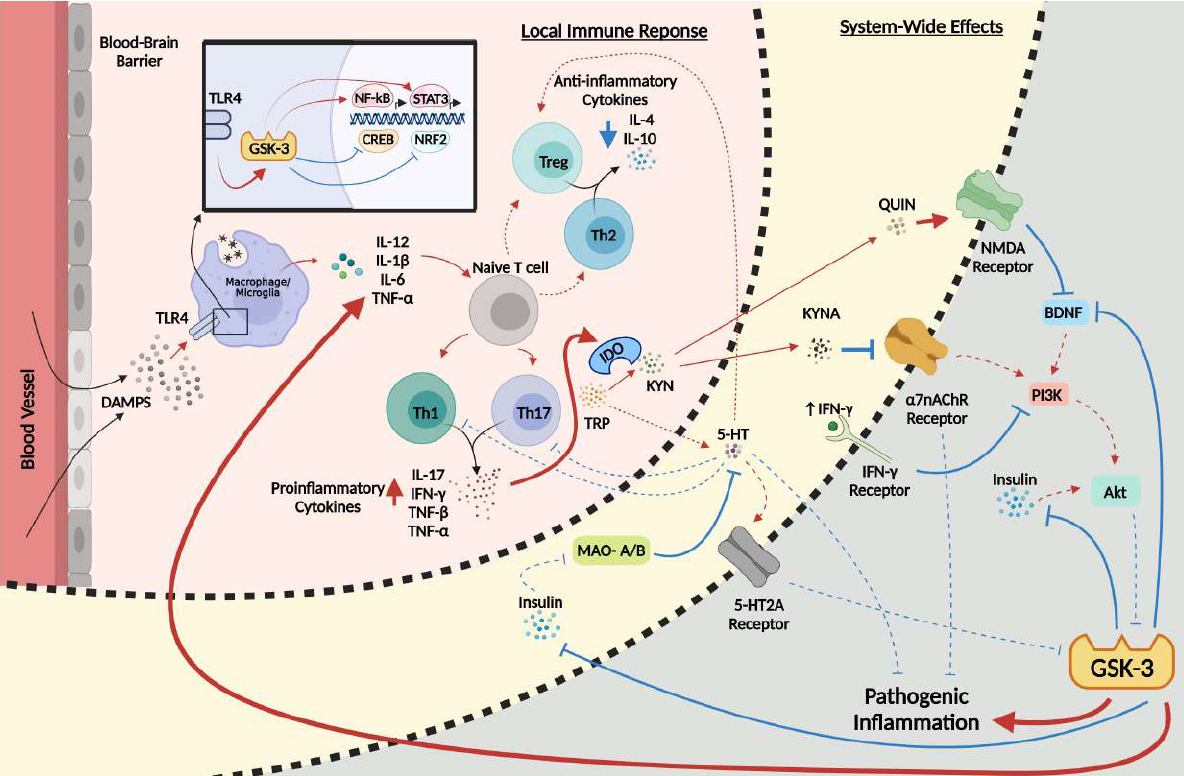
Figure 1. Multifaceted involvement of GSK-3 in promoting MDD neuropathology. Several bidirectional signaling pathways work cooperatively to elevate GSK-3 activity in MDD. Such processes, initiating from the DAMP-mediated activation of